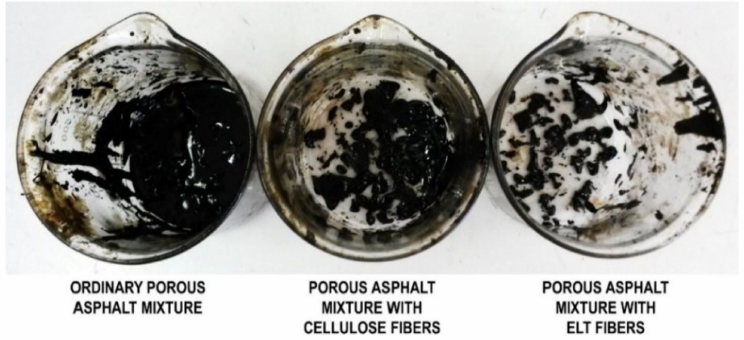
Figure 11. Effect of the fiber type in reducing bitumen drain down from porous asphalt mixtures